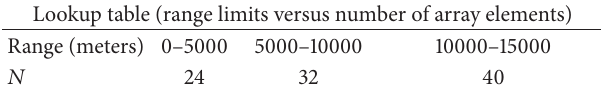
Table 4: Lookup table maintained by the selector.